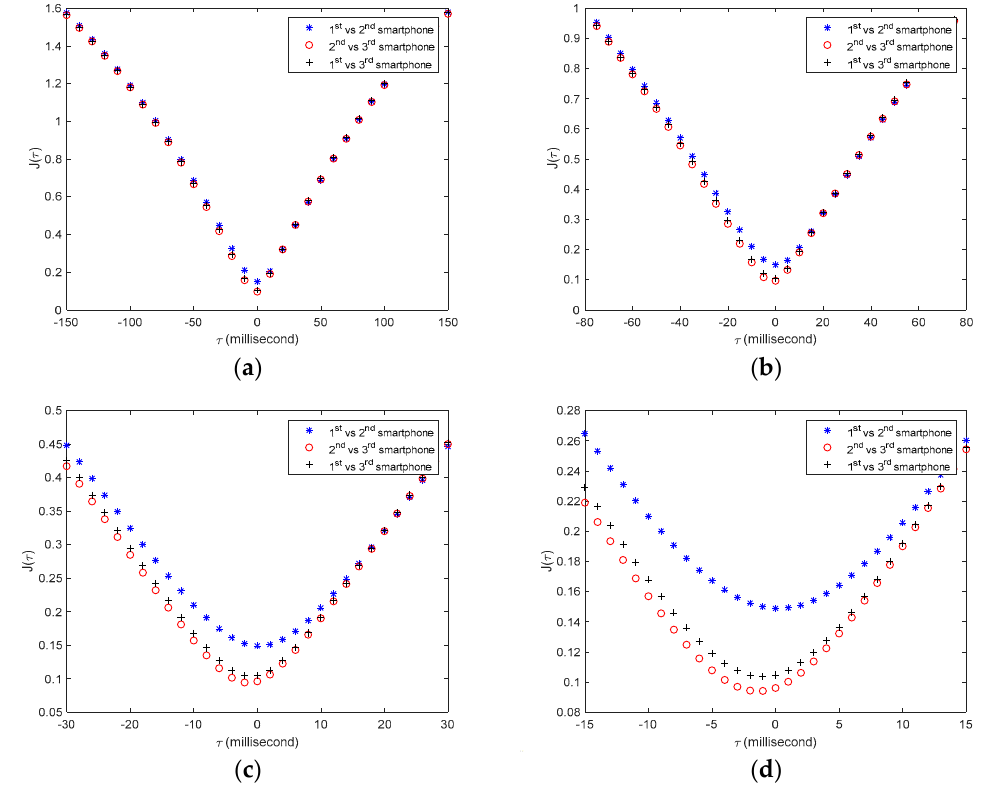
Figure 15. Time synchronization indices 𝐽(𝜏) calculated from up-sampled structural response with different time intervals: ( a ) n = 2, dt = 0.01 s; ( b ) n = 4, dt = 0.005 s; ( c ) n = 10, dt = 0.002 s; ( d ) n = 20, dt = 0.001 s. Table 2. Time synchronization errors with different upsampling rates (millisecond). Upsampling Rate n 1st Phone vs.2nd